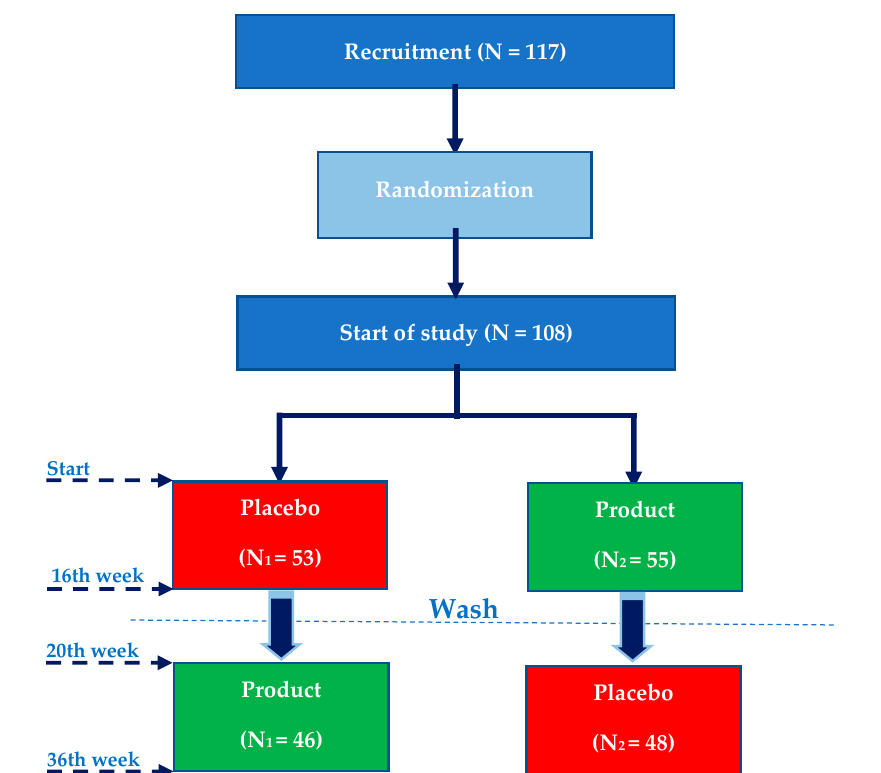
Figure 1. Phases of the intervention study. N1 = group 1 randomly selected. N2 = group 2 randomly selected.